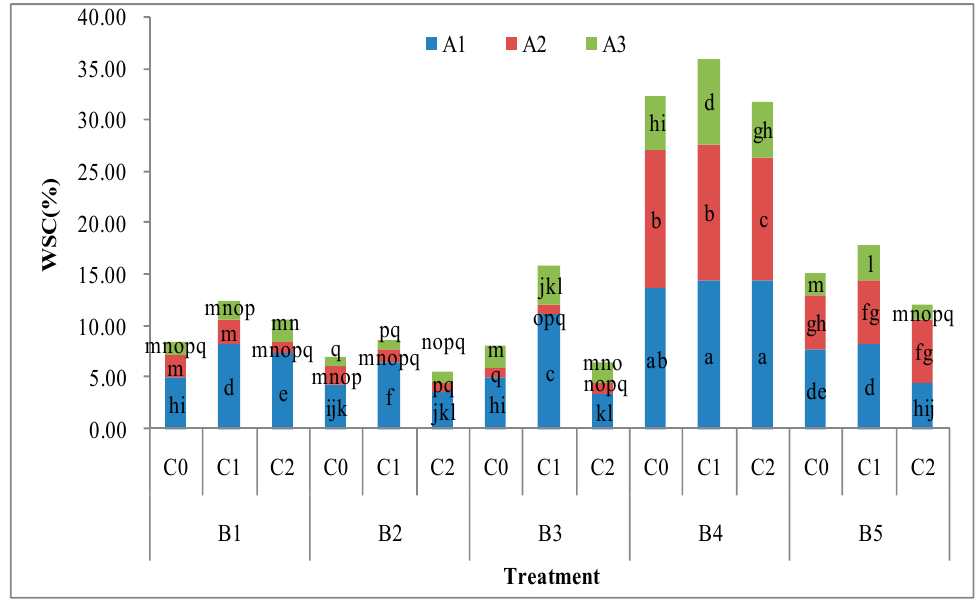
Figure 4. Differences in WSC content for the interaction between forage species, cutting stages and additives. Different letters mean significant differences at p < 0.05. WSC: water-soluble carbohydrate.